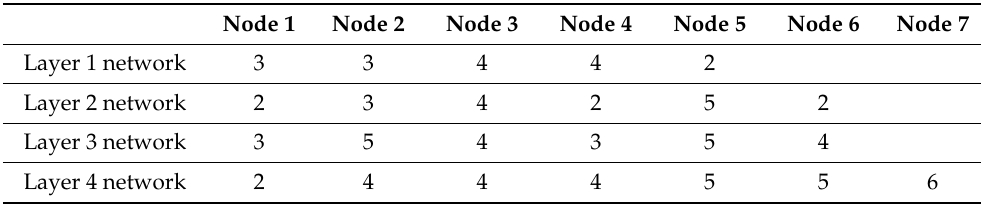
Table 3. Degree of nodes in each layer of the network.